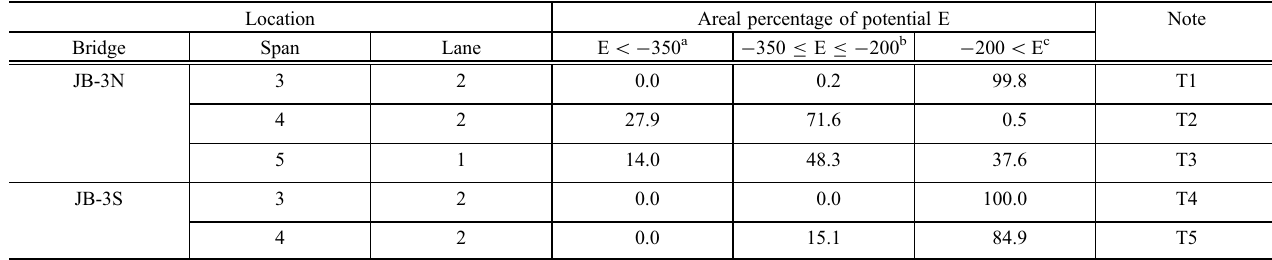
Table 5 Corrosion potential measured by half-cell